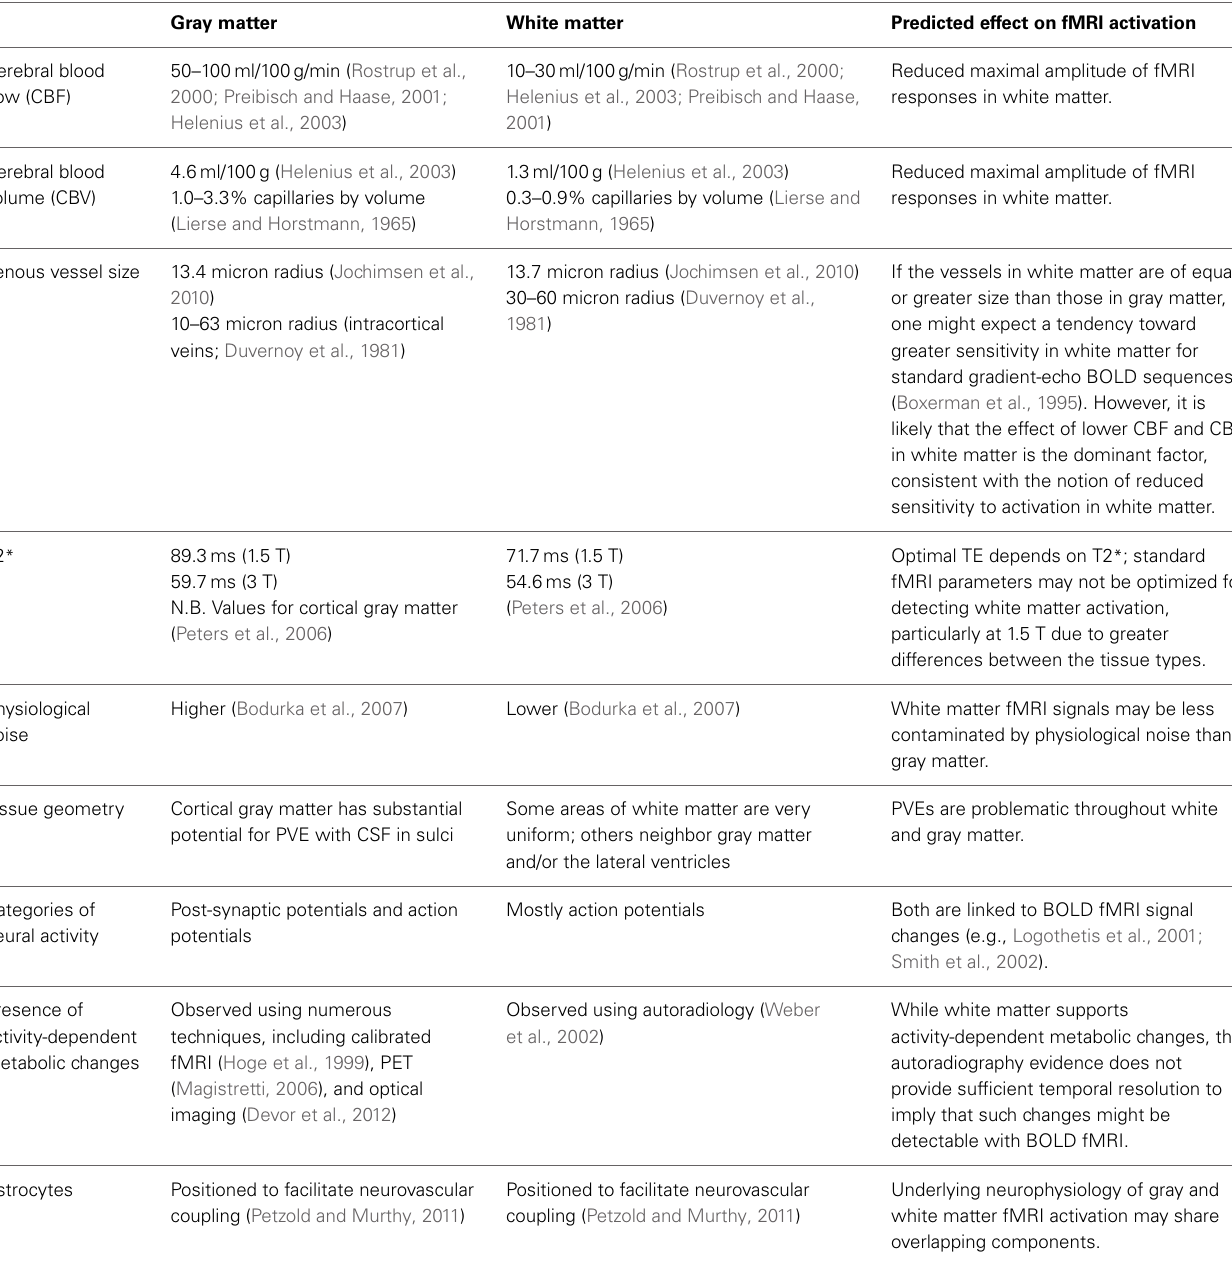
Table 1 | Factors that influence the ability to detect fMRI activation and how they differ across tissue types. White